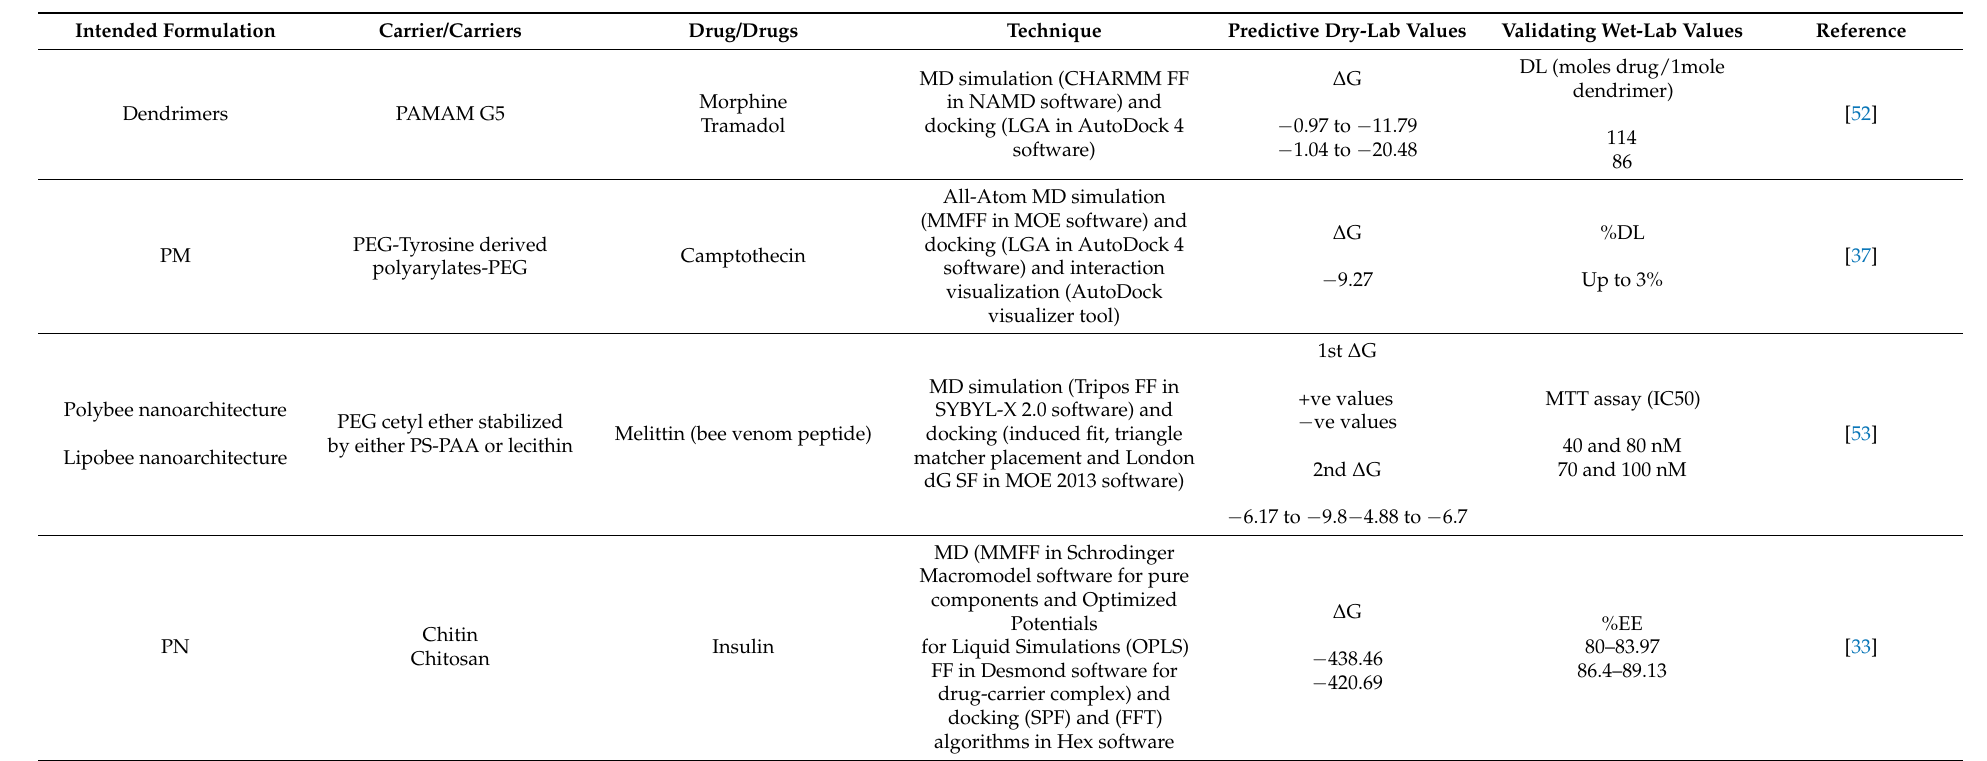
Table 5. Cases of contradictory wet lab-dry lab results explained only by binding site